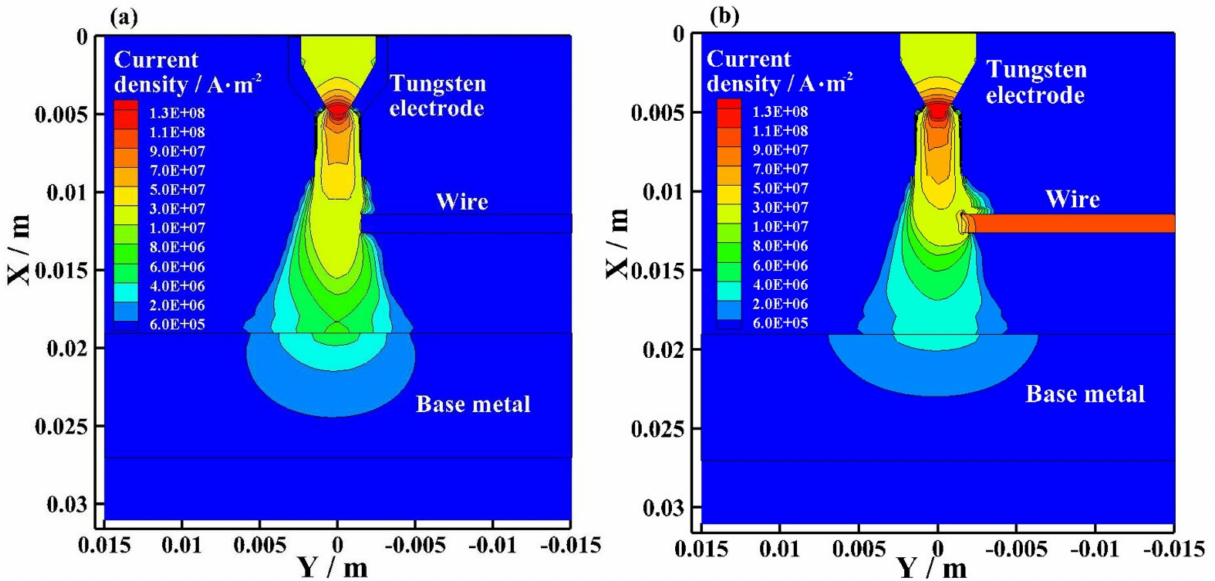
Figure 10. Current density distribution of bypass coupling arc at EP phase with and without bypass current, ( a ) 120 A and 0 A, ( b ) 60 A and 60 A.